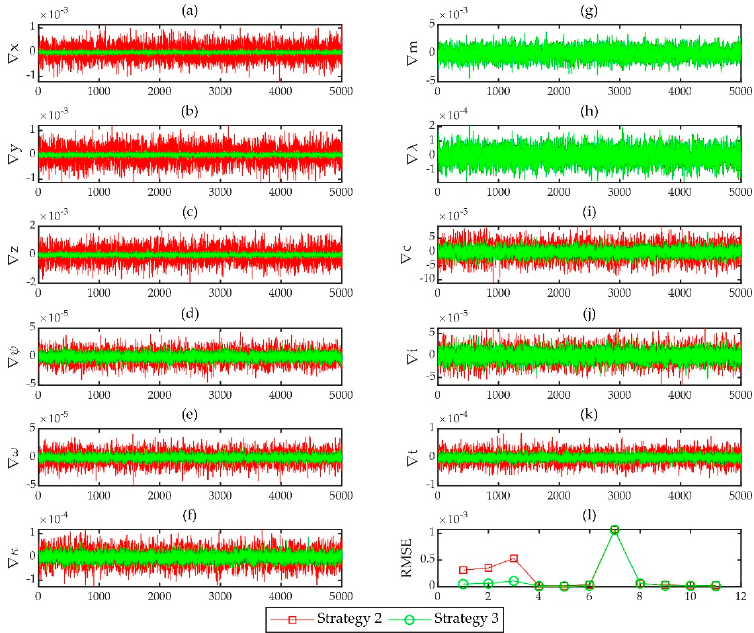
Figure 6. The di ff erence sequences of parameters in Case 2 with its RMSE where the horizontal axis indicates the experiment serial number from (a) to (k) and parameters’ serial number in (l). ( a ) ∇ x